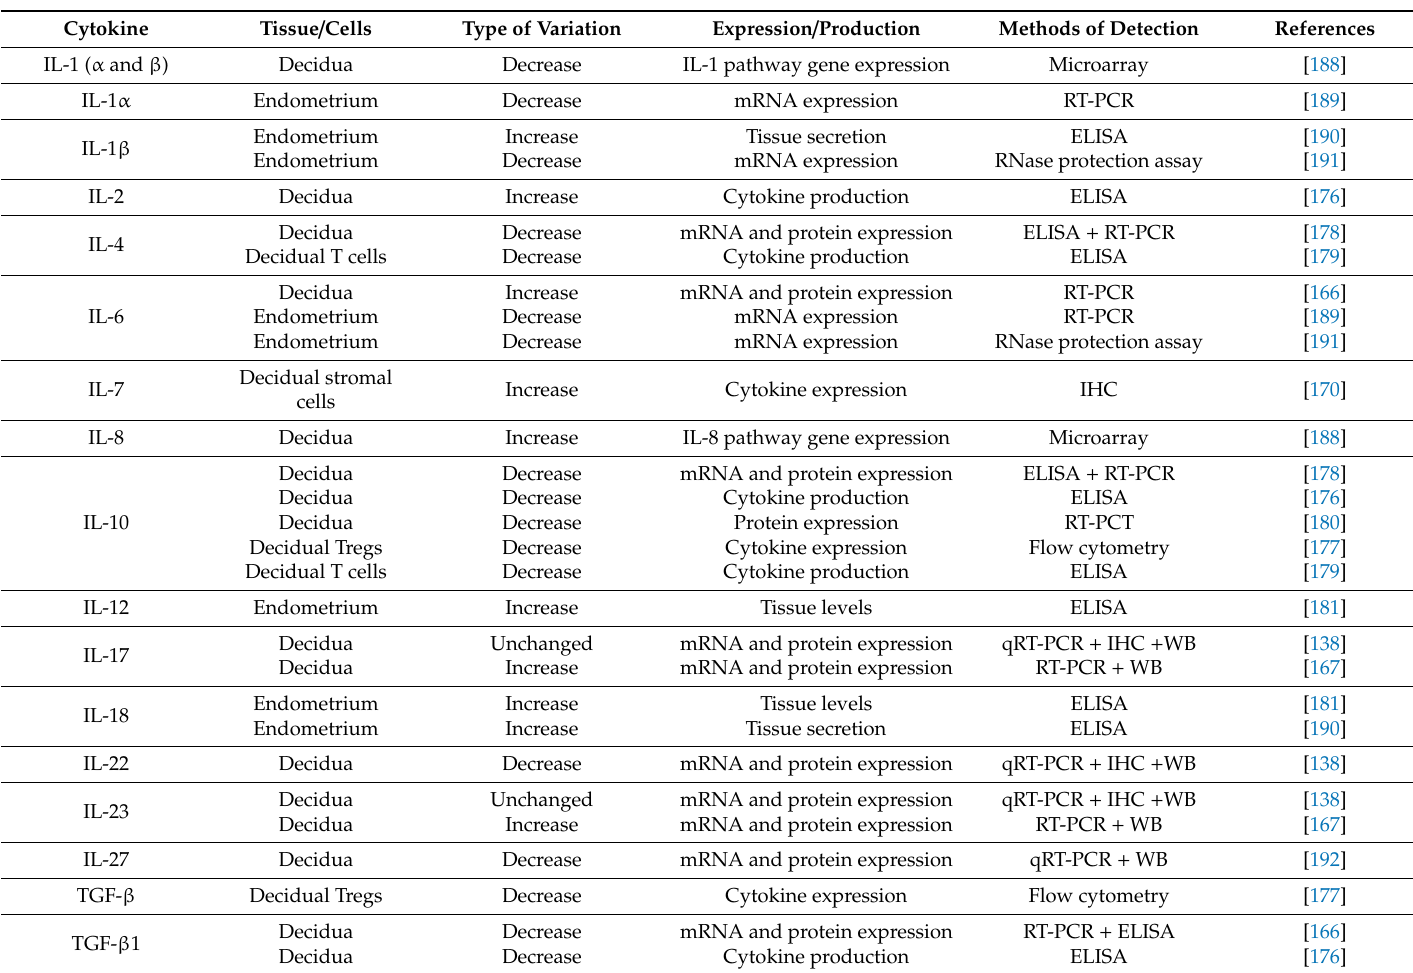
Table 5. Summary of the major changes observed in cytokine expression / levels in the endometrium and decidua in women with RPL compared with normal